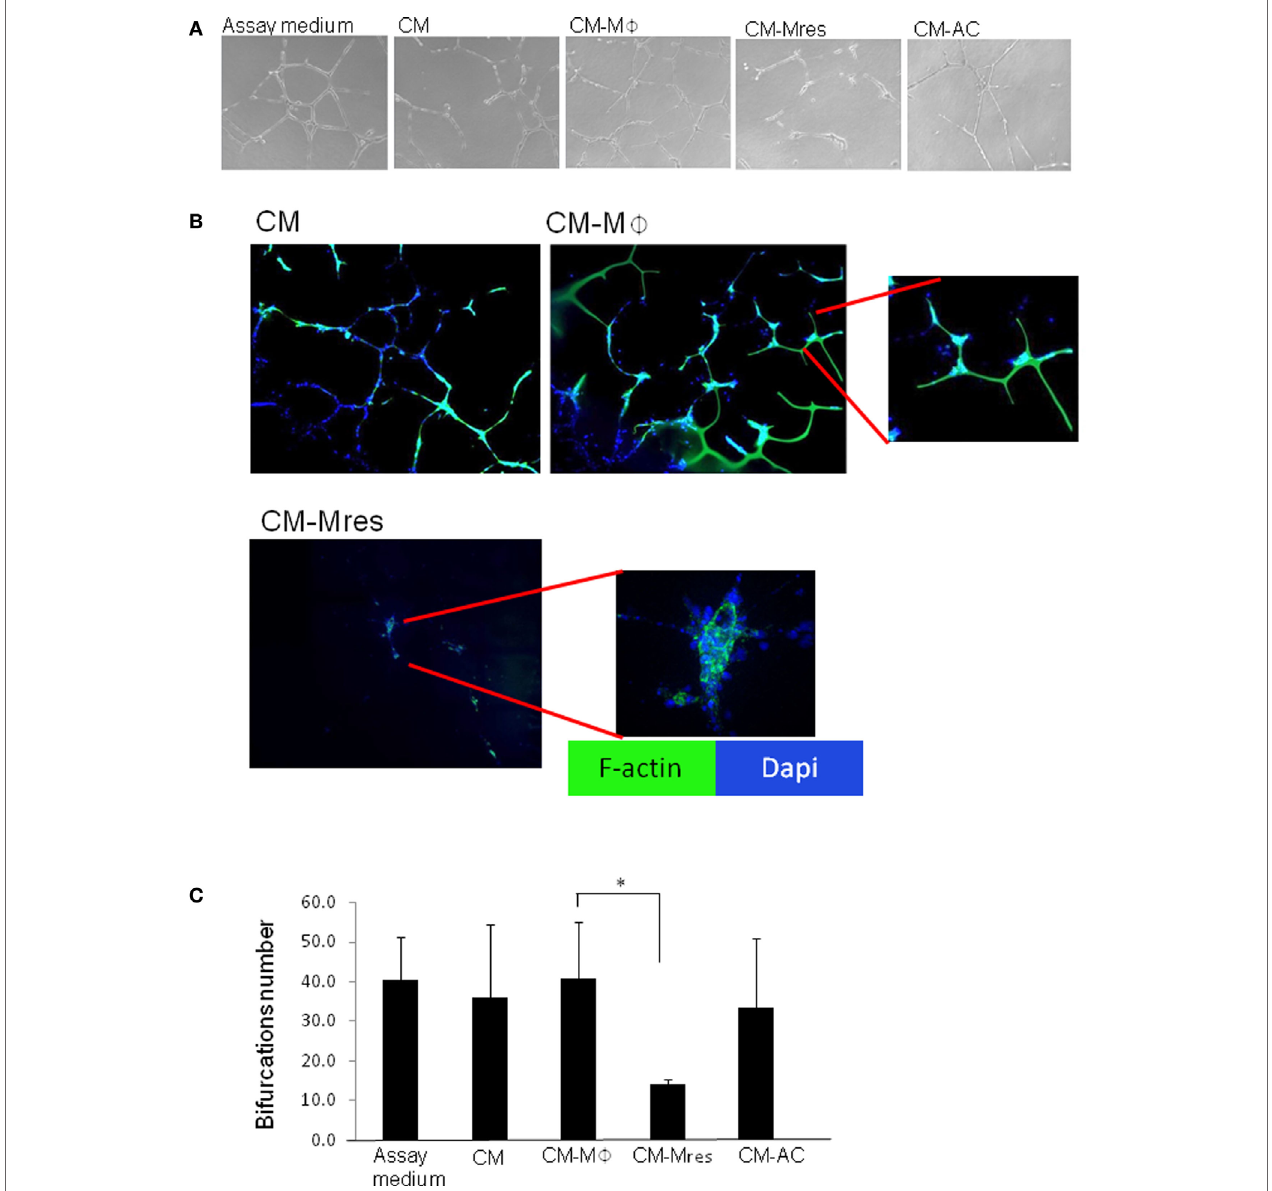
FigUre 3 | CM-Mres hinders human umbilical vein endothelial cell (HUVEC) differentiation to tubular-like structures. HUVECs were cultured on basement membrane extract for 16–19 h with Assay Medium, condition medium (CM), CM-M ϕ , CM-Mres, or CM-AC. (a) Representative light microscopy images ( n = 5). Magnification 10 × . (B) Fluorescence staining of HUVEC cells for F-actin (phalloidin; green) and nuclei (DAPI; blue). Representative confocal images are shown. Magnification 40 × . Bars = 50 μ m. (c) Quantification of the bifurcation number of vessel-like tubular structures obtained from three to five microscopic fields. Columns; mean, bars; STD, n = 5, one-way repeated measures ANOVA analysis with repeated contrasts, * p <